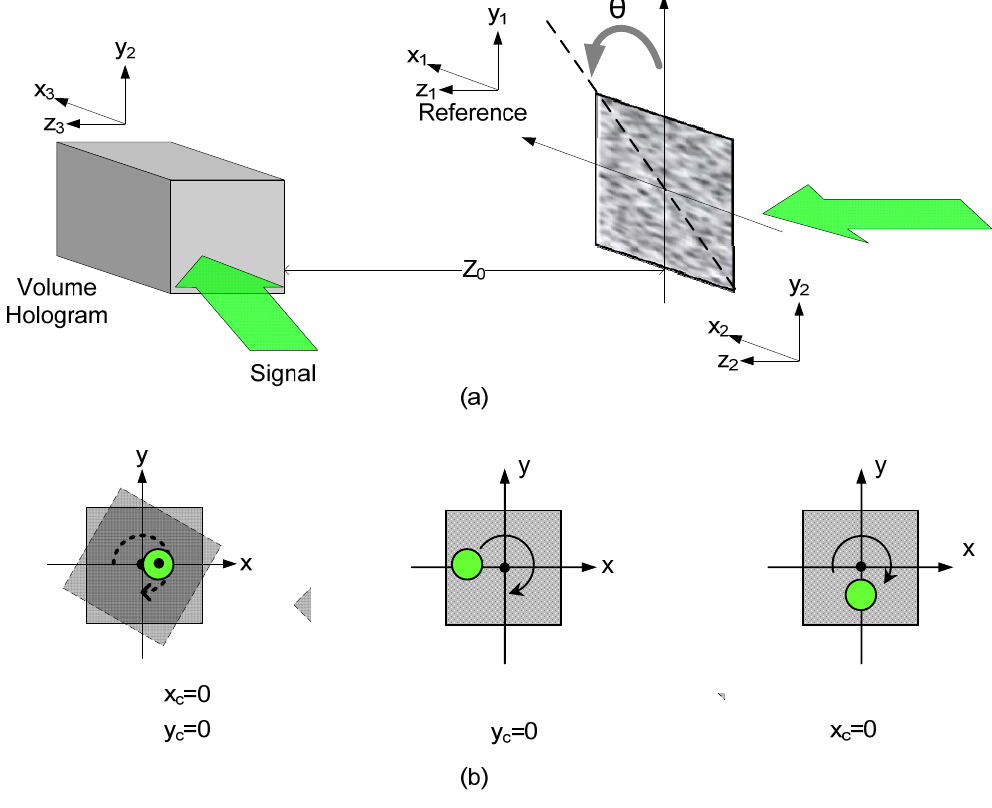
Figure 4. ( a ) Schematic diagram of the rotational random phase encoding for volume holograms; ( b ) Three different locations of the illumination area on the ground